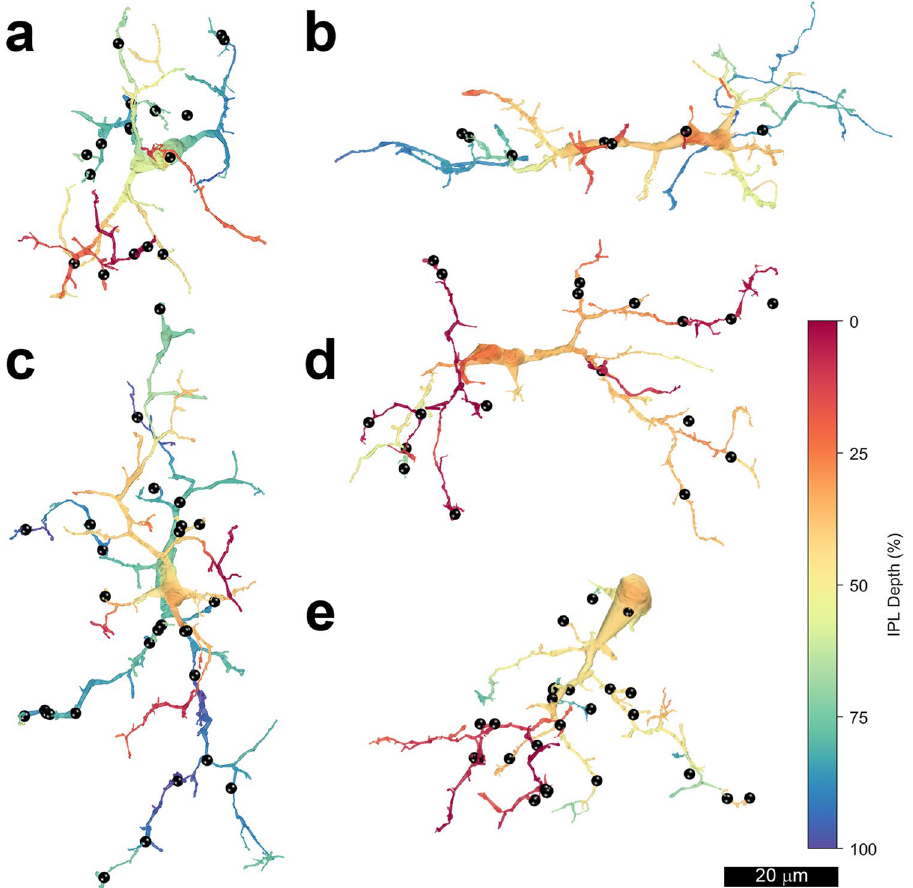
Figure 3. Renders of individual of microglial cells: ( a ) 50688, ( b ) 50640, ( c ) 50636, ( d ) 1 and ( e ) 50635. The depth of processes in the inner plexiform layer is indicated by pseudocolors; 0% (red) is the inner nuclear layer and 100% (blue) is the ganglion cell layer. Locations of trogocytosis are indicated ( ● ). Note that the 5 microglia vary in the numbers and distribution of the sites of